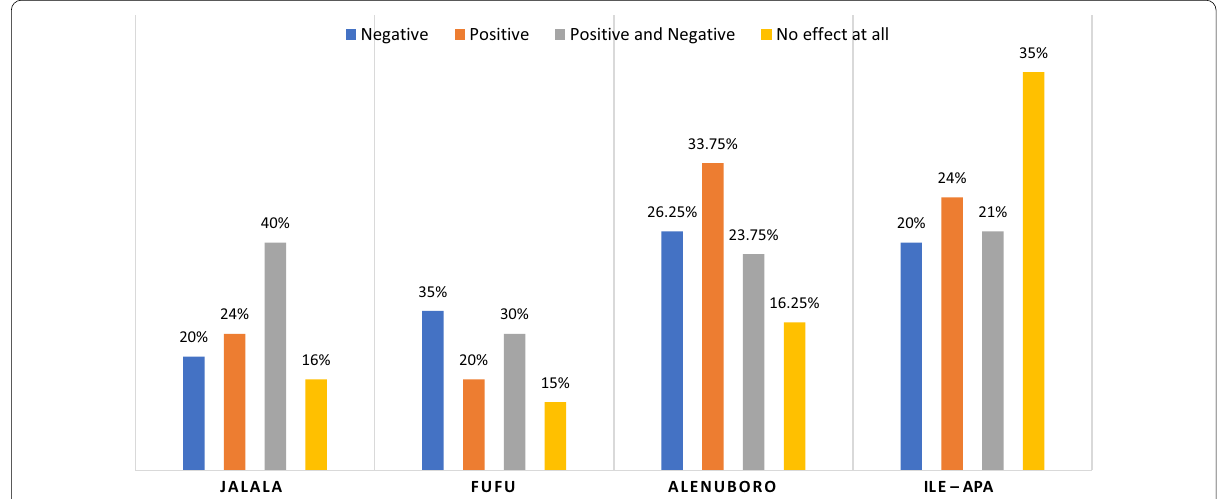
Fig. 2 Percentage impact of climate change on rural women’s livelihood in Ilorin South LGA Source Authors Analysis,